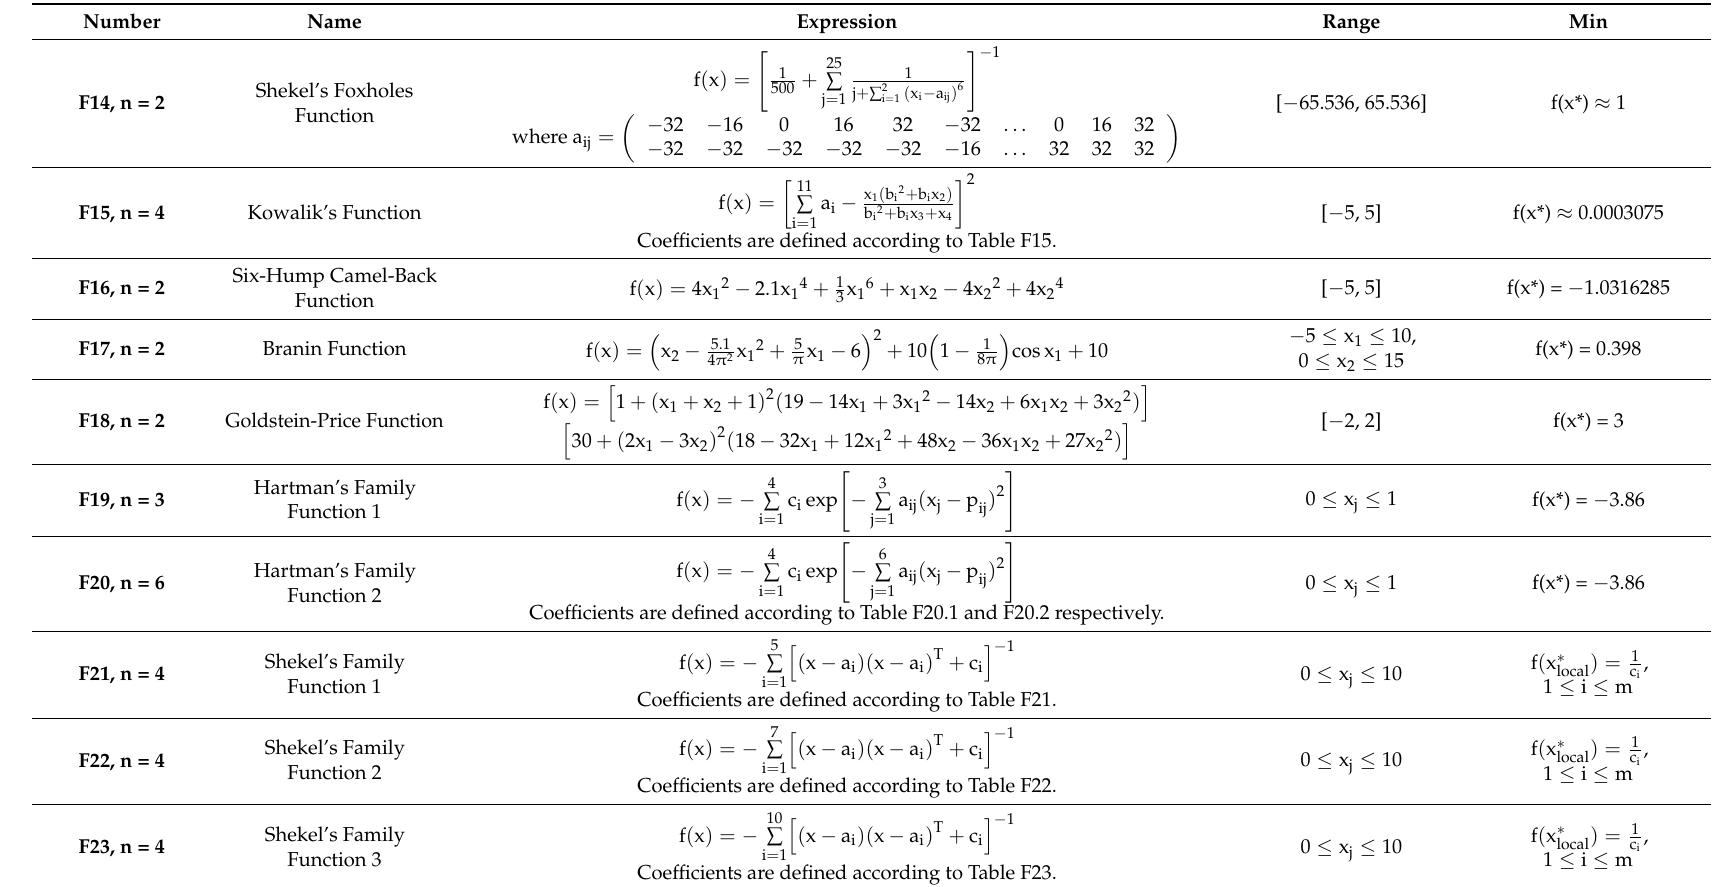
Table 4. Multimodal test functions with fixed dimensions considered for